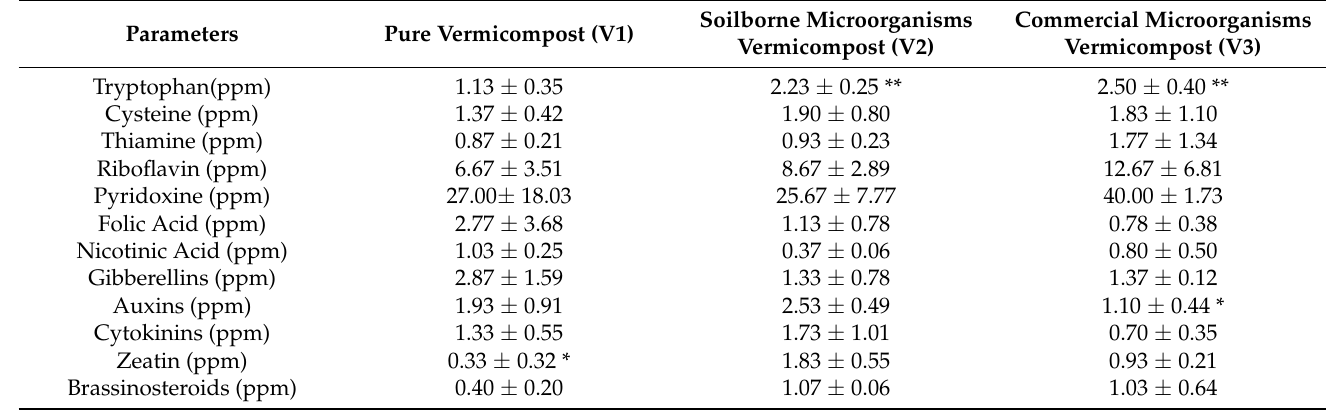
Table 4. The identification and quantification of amino acids and hormones were evaluated in each treatment with three replicates (mean ± standard deviation).